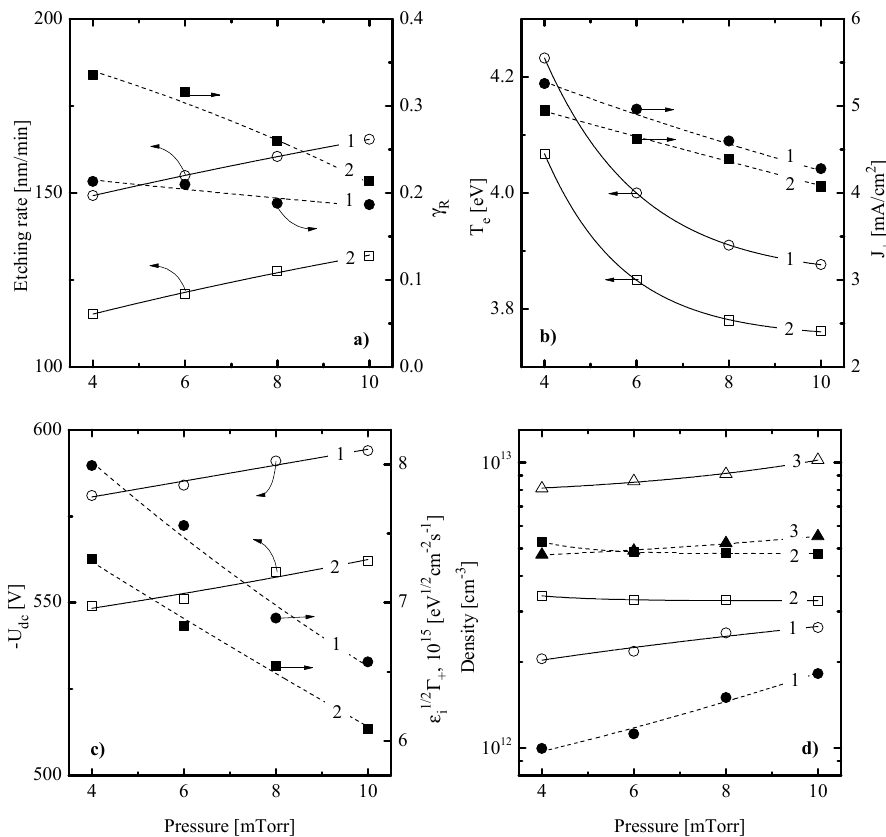
Figure 3. E ff ect of gas pressure on SiO x N y etching kinetics ( a ) and plasma characteristics ( b–d ) at W = 100 W for 45% CF 4 + 45% C 4 F 8 (CF 2 Br 2 ) + 10% O 2 gas mixtures: %: ( a ) etching rate and effective reaction probability; ( b ) electron temperature and ion current density; ( c ) negative dc bias and the √ ε Γ + parameter characterizing ion energy flux; and ( d ) atoms and radical densities. Numerical labels on curves are as in Figure 1.